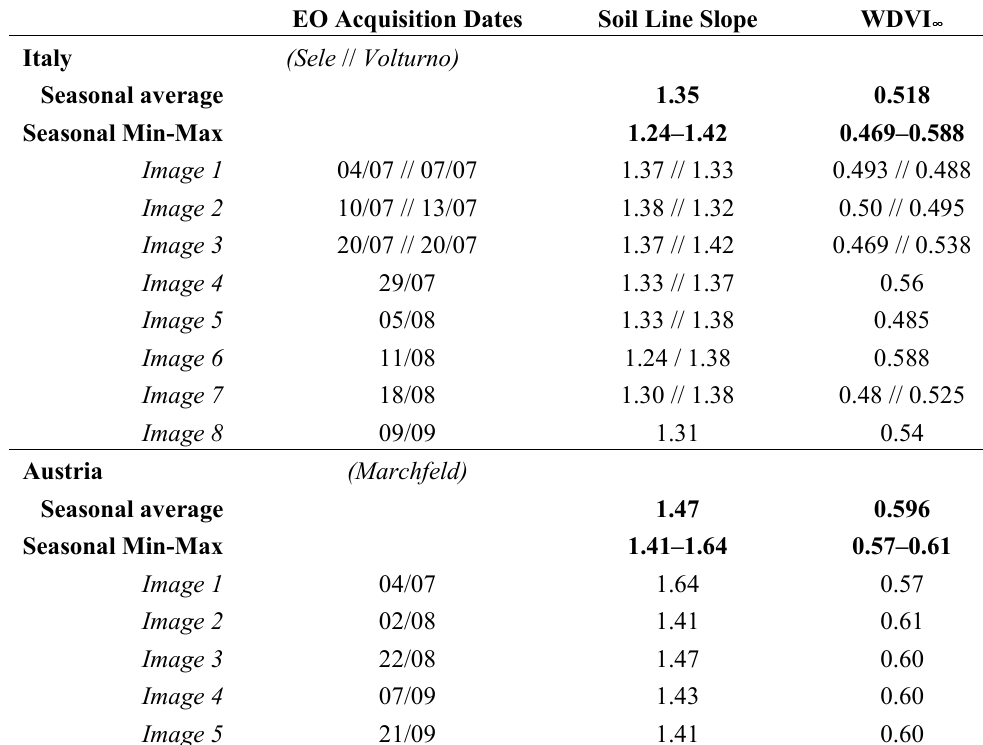
values for each satellite image in the two study ∞ values were used for procedure 2 and 3. ∞